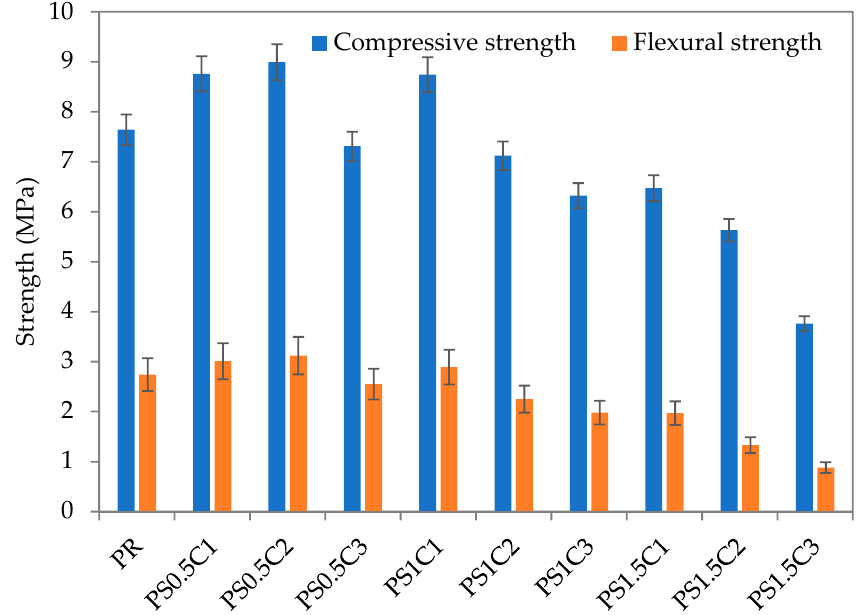
Figure 4. Compressive and flexural strength of plasters.